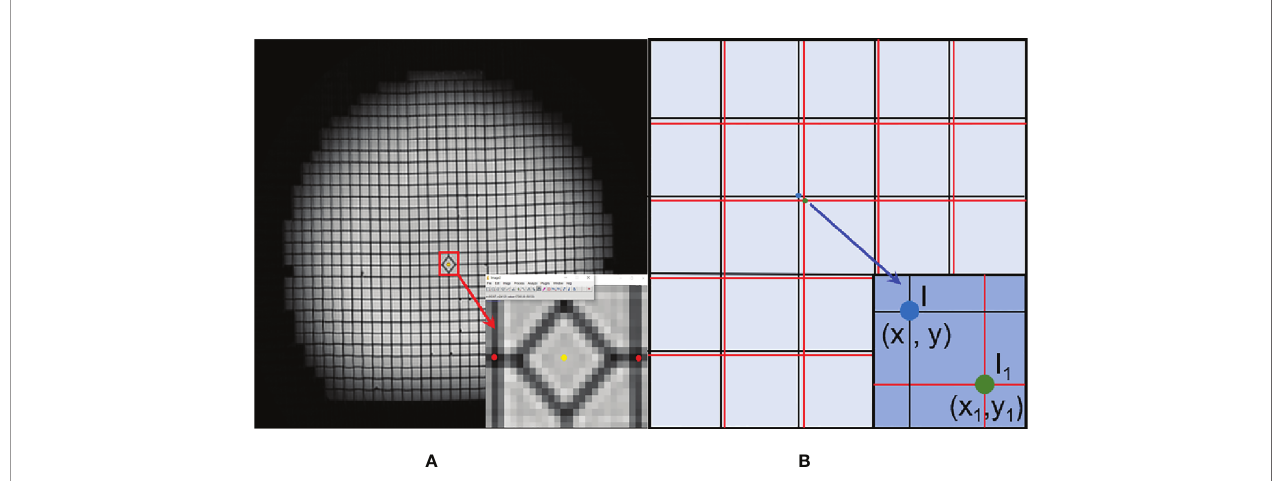
FIGURE 2 | Schematic diagram of the geometric distortion obtaining process. (A) The center point (yellow point) and distortion points (red points) in the enlarged image. (B) The registered CT and MR image. The black grids represent the reference CT image, and the red line represents the MR image.